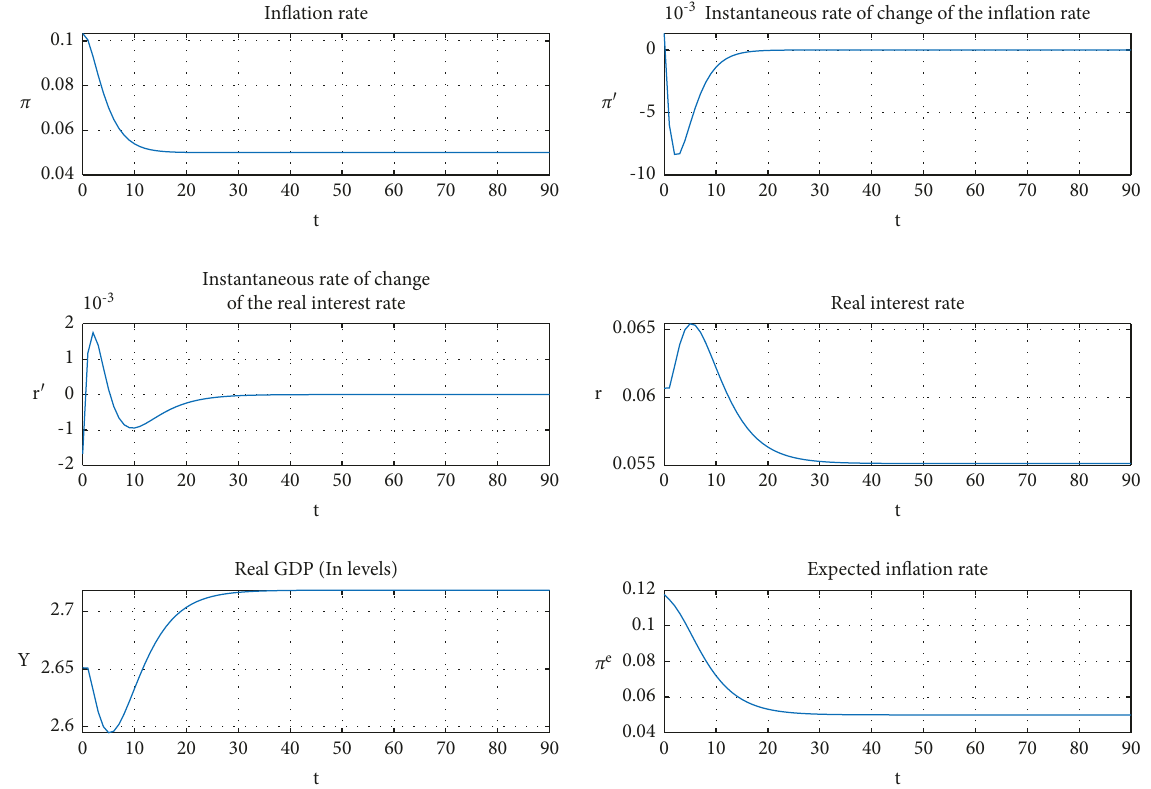
Figure 6: Time paths of the interest rate, real GDP, inflation, expected inflation, and instantaneous rates of change of the interest rate and inflation.